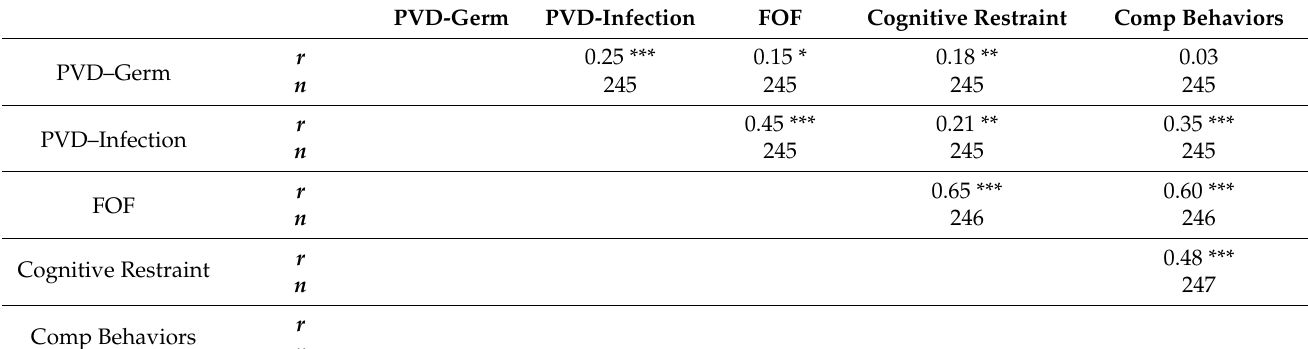
Table 2. Zero-Order Correlation Matrix PVD, FOF, Cognitive Restraint, and Compensatory Behaviors. PVD-Germ